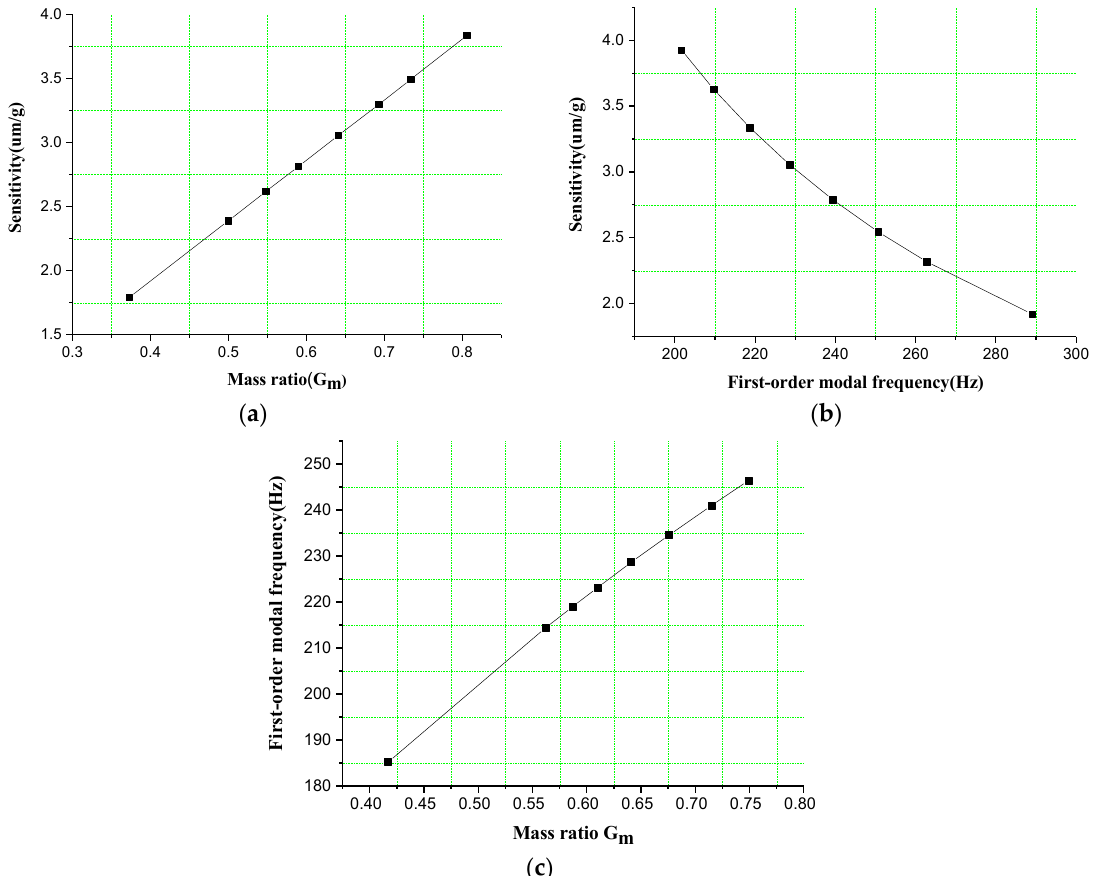
Figure 4. The effect of mass ratio and first-order modal frequency on mechanical sensitivity ( a ) The relationship between mechanical sensitivity and mass ratio in the same first-order modal frequencies; ( b ) The relationship between mechanical sensitivity and first-order modal frequencies in the same mass ratio; ( c ) The relationship between mass ratio and first-order modal frequency in the same mechanical sensitivity.